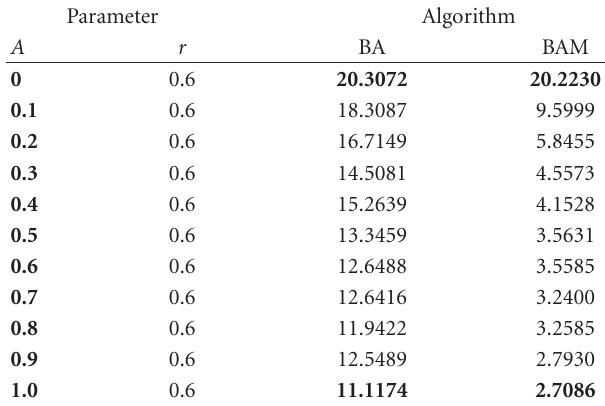
Table 12: Mean normalized optimization results on UCAV path planning problem on di ff erent A . The numbers shown are the minimum objective function values found by BA and BAM algorithms, averaged over 100 Monte Carlo simulations.